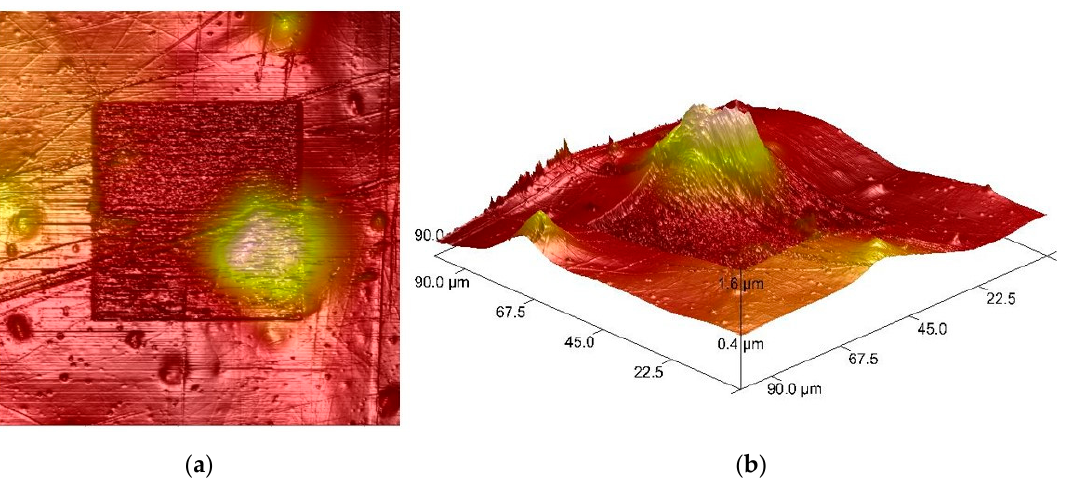
Figure 8. Surface topography of sample g-0.5 after scratching the surface with a first 50 µ m by 50 µ m scan area at a set-point voltage of 4 V, and a subsequent 100 µ m by 100 µ m scan area at a set-point voltage of 0 V: ( a ) top view and ( b ) 3D image.